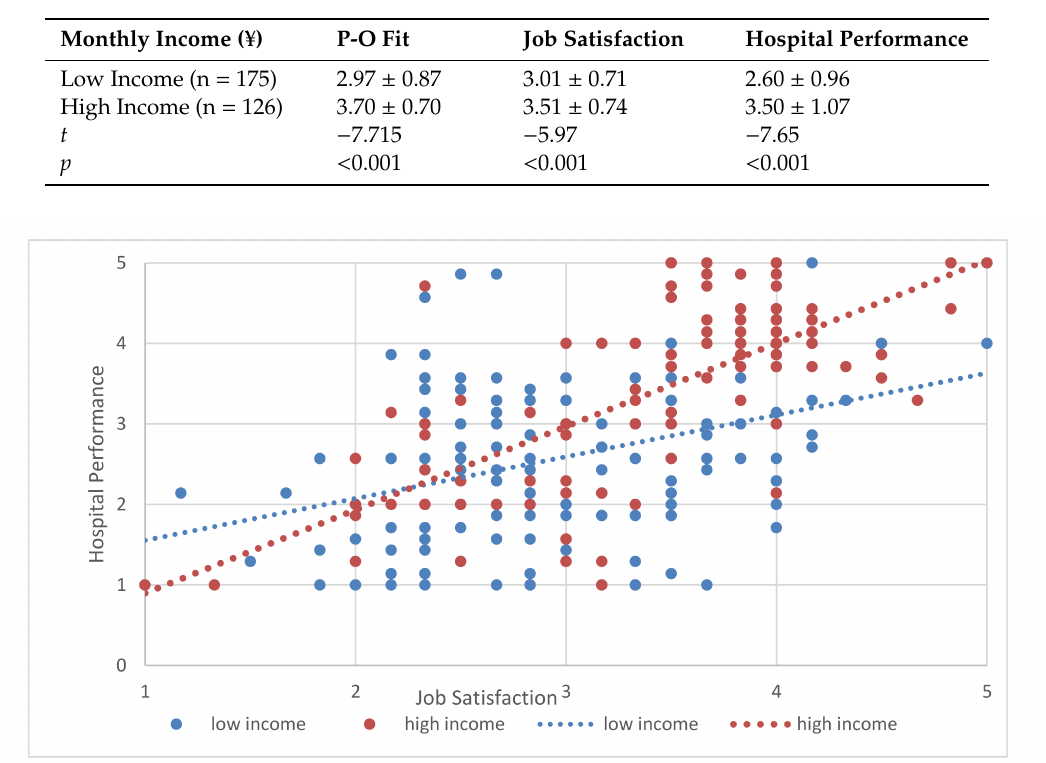
Table A1. Measurement scores (Mean ± SD) in the study participants with high ( > ¥5000 yuan) and low ( ≤ ¥5000 yuan) income.